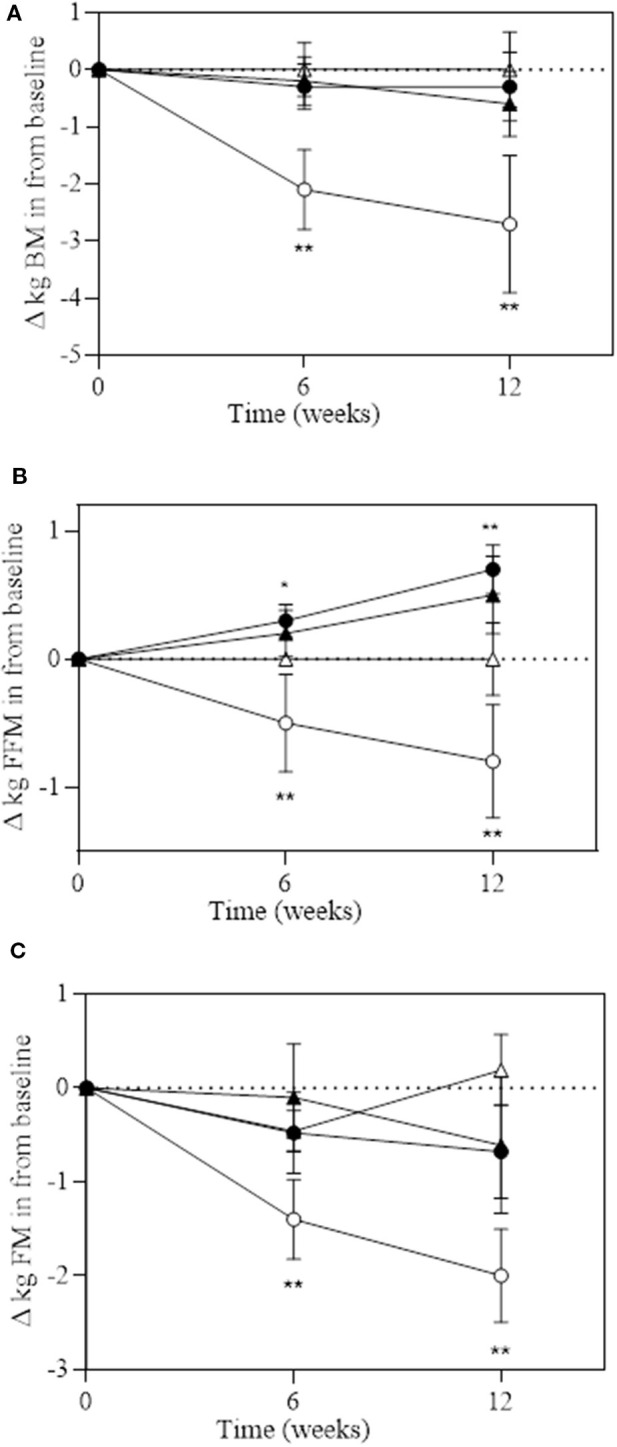
Change over 6 and 12 weeks of intervention trial from baseline for (A) total body mass (in kilograms); (B) fat-free mass (in kilograms); and (C) fat mass (in kilograms) according to group: DM (high-protein milk beverage, open circle), EX+DM (exercise + high-protein milk beverage, filled circle), EX (exercise, filled triangle), and CON (control, open triangle). Mean ± SEM: **P < 0.01 and *P < 0.05 vs. baseline.